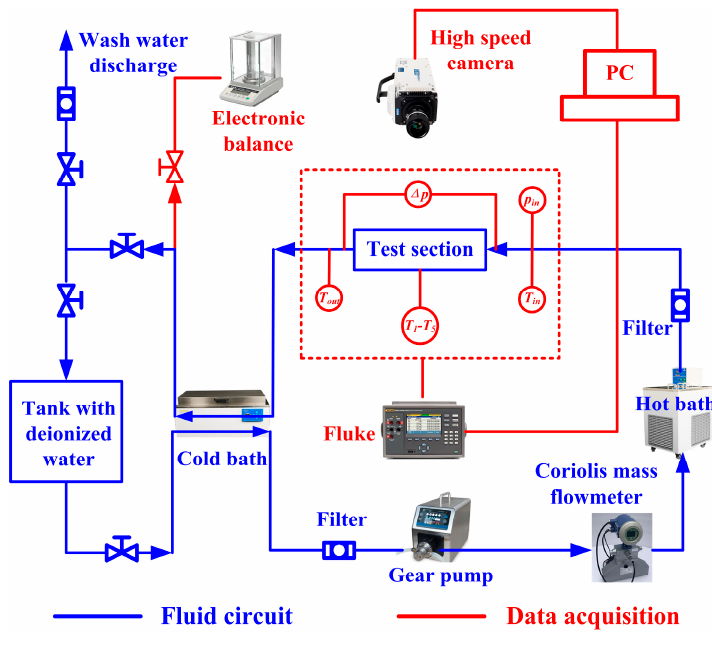
Figure 4. Schematic diagram of the experimental set-up.